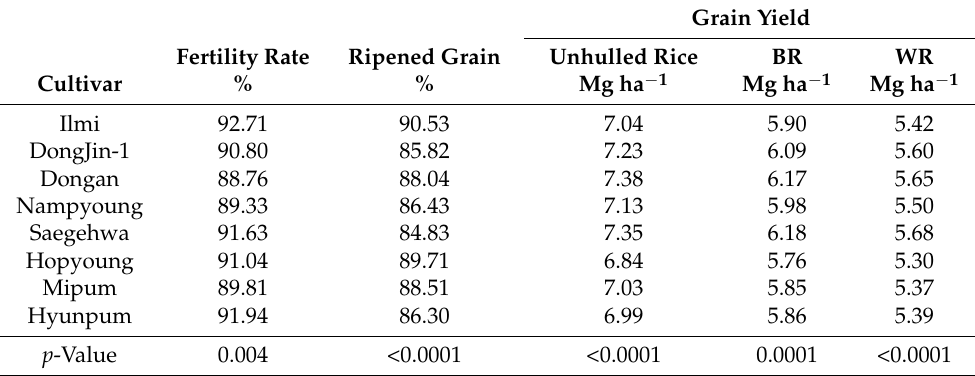
Table 4. Fertility rate, ripened grain, and grain yield of unhulled rice, brown rice (BR), and white rice (WR) of all eight cultivars used in this study. All cultivars were statistically compared at α = 0.005 for each